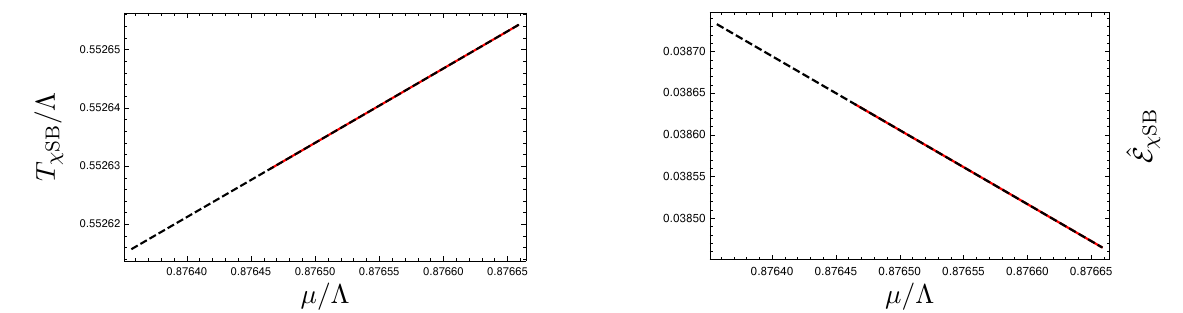
Figure 33 . The critical Klebanov-Tseytlin black holes for µ num < µ num , max (dashed black curves in figure 32) and µ num > µ num , max (red curves in figure 32) have identical values of T χ SB / Λ (left panel) and ˆ (right panel) as a function of µ/ E χ SB